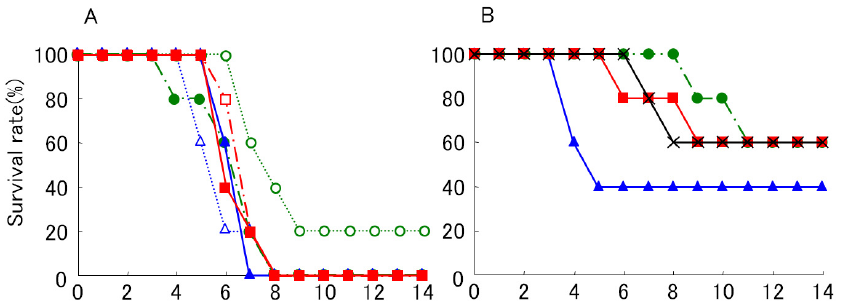
Figure 1. Survival curves of young chicks subcutaneously inoculated with WN virus 6-LP ( A ) and 6-SP ( B ) variants. Two days old male chicks were inoculated with 10 − 1 ( ○ ), 10 0 △ ( ), 10 1 ( ☐ ), 10 2 ( ● ), 10 3 ( ▲ ) and 10 4 ( ■ ) PFU of 6-LP, and 10 2 ( ● ), 10 3 ( ▲ ), 10 4 ( ■ ) and 10 5 (×) PFU of 6-SP. Chicks were observed daily for health conditions. The number of chicks used was 5 for each